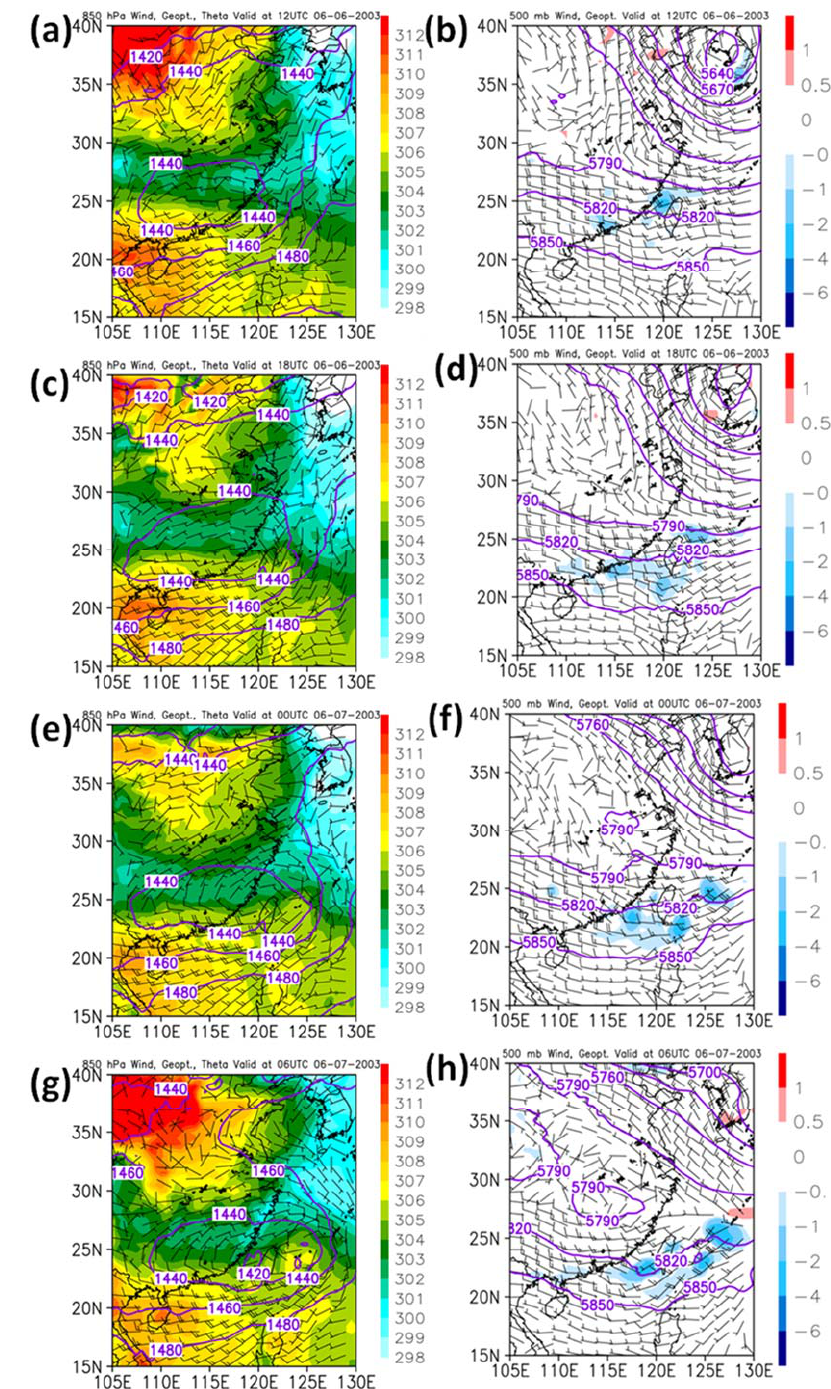
Figure 3. The CFSR geopotential height (gpm, contoured), potential temperature (K, shaded), and winds (V; m s − 1 ) (full barb and half barb represent 10 and 5 m s − 1 , respectively) at 850 hPa at ( a ) 1200 UTC (2000 LT) 6 June; ( c ) 1800 UTC 6 June (0200 LT 7 June); ( e ) 0000 UTC (0800 LT) 7 June; and ( g ) 0600 UTC (1400 LT) 7 June 2003. ( b , d , f , h ) are at the same time as ( a , c , e , g ), respectively, but for vertical motion (Pa s − 1 , shaded), geopotential height (gpm, contoured), and wind (V; m s − 1 ) at 500